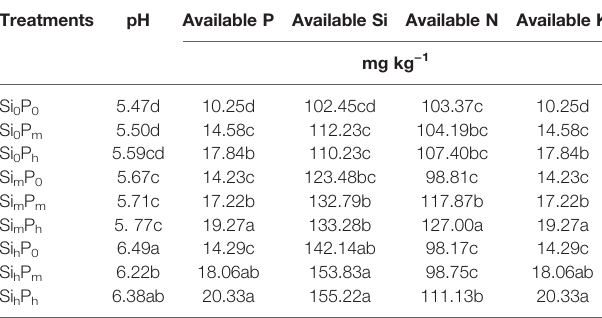
TABLE 2 | Soil pH value and available silicon (Si) and phosphorus (P) contents under different levels of Si and P supply * .